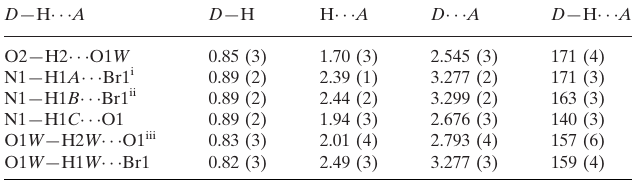
Hydrogen-bond geometry (A˚ , (cid:4) ). D —H (cid:2)(cid:2)(cid:2) A D